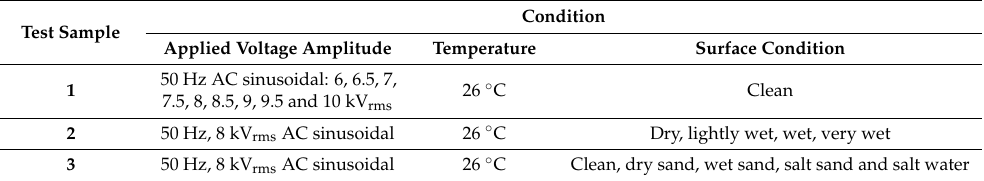
Table 2. Conditions of each test